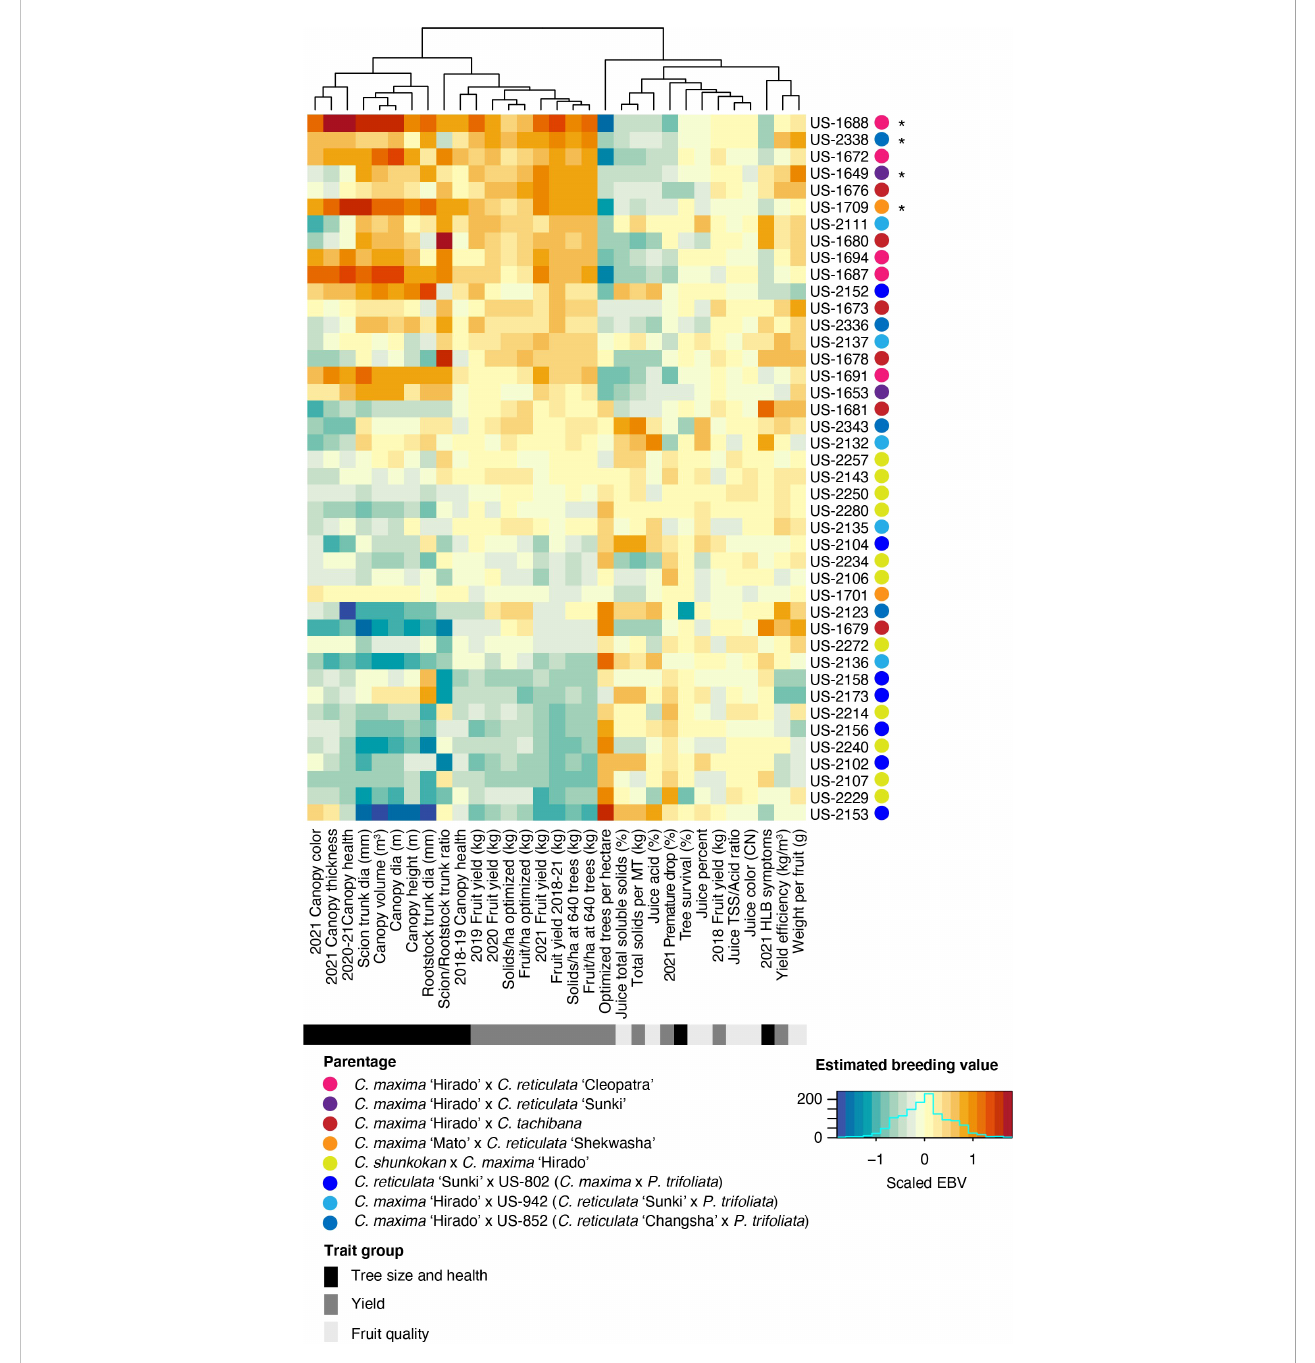
FIGURE 3 Estimated breeding value of rootstock hybrids. REML linear mixed models for each trait were used to predict the EBV of each hybrid. Each row represents a hybrid with the name listed on the y-axis. Hybrids were ordered from highest to lowest fruit yield (2018-2021), with higher yielding hybrids on the upper portion of the heatmap. The parentage of each hybrid is indicated in the key. Trait names are shown on the x-axis and traits were grouped into three broad categories: tree size and health, yield, and fruit quality. The estimated breeding values for each trait/hybrid combination are relative to the intercept of each model with positive values represented by warmer orange and red colors and negative values by cooler blue